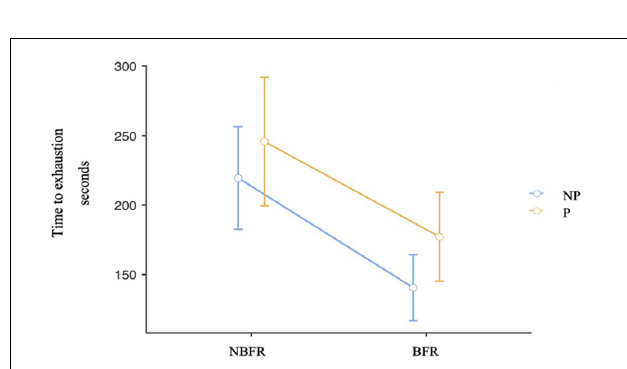
FIGURE 6 | Analysis of the TTE in PC and O 2 saturation conditions. Mean value comparison and 90% CI of the time to exhaustion in all conditions. NP = No perturbation, P = Perturbation, NBFR = No